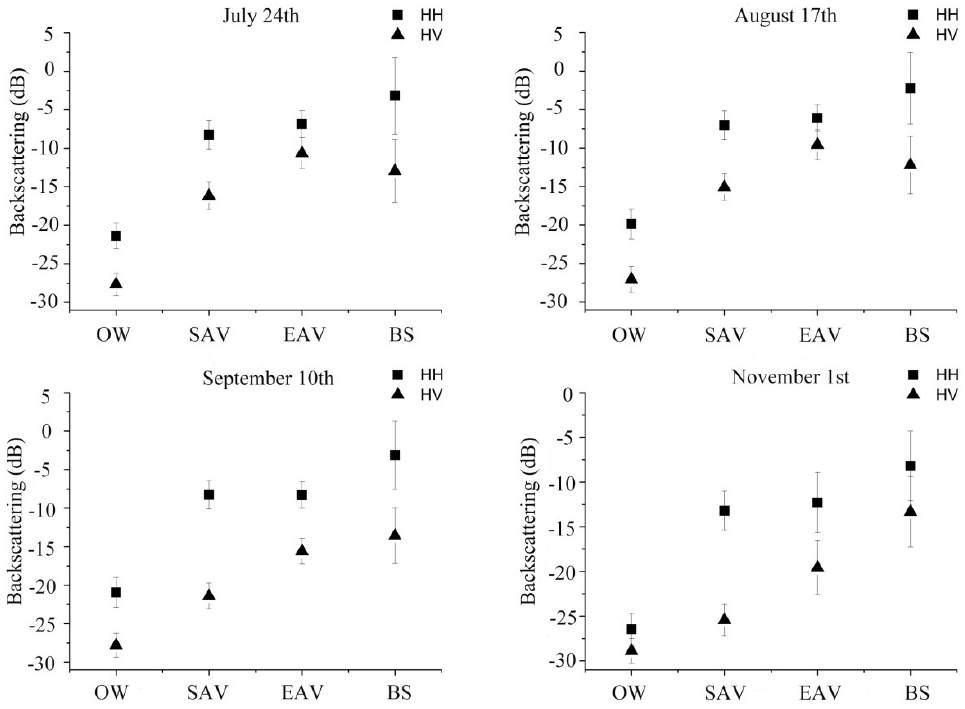
Figure 2. Backscattering coefficients of Radarsat-2 HH and HV for different flooding situations (OW = open water, SAV = submerged aquatic vegetation, EAV = emerged aquatic vegetation, BS = bare soil) in 2015.